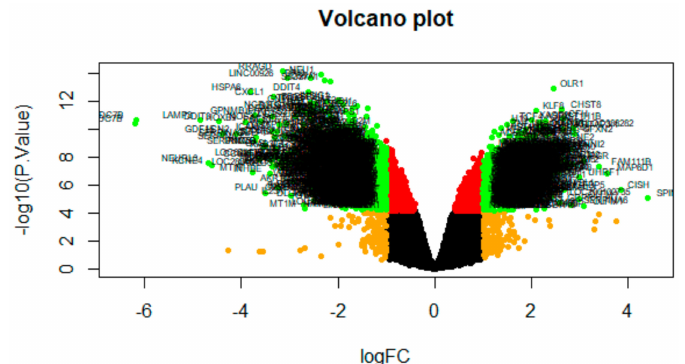
Figure 3. Volcano plot of di ff erentially expressed genes. Genes with a significant change of more than two-fold were